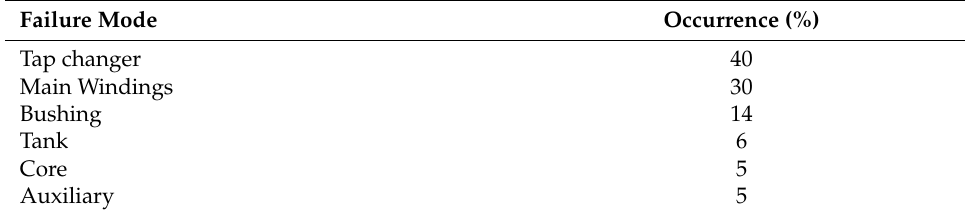
Table 1. Power transformer failure modes according to CIGRE international survey [1].